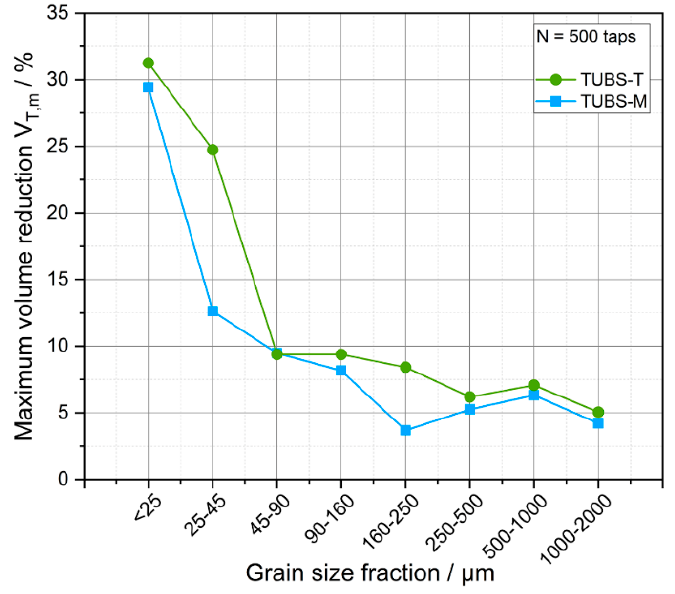
Figure 8. Maximum volume reduction at N = 500 taps as a function of the particle size fractions.